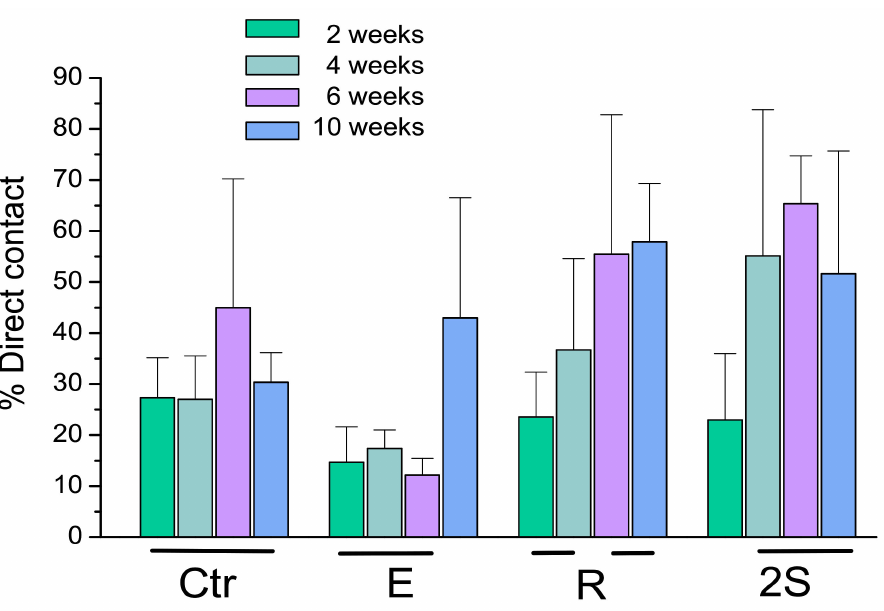
Figure 11. Bone in contact at different times of implantation.